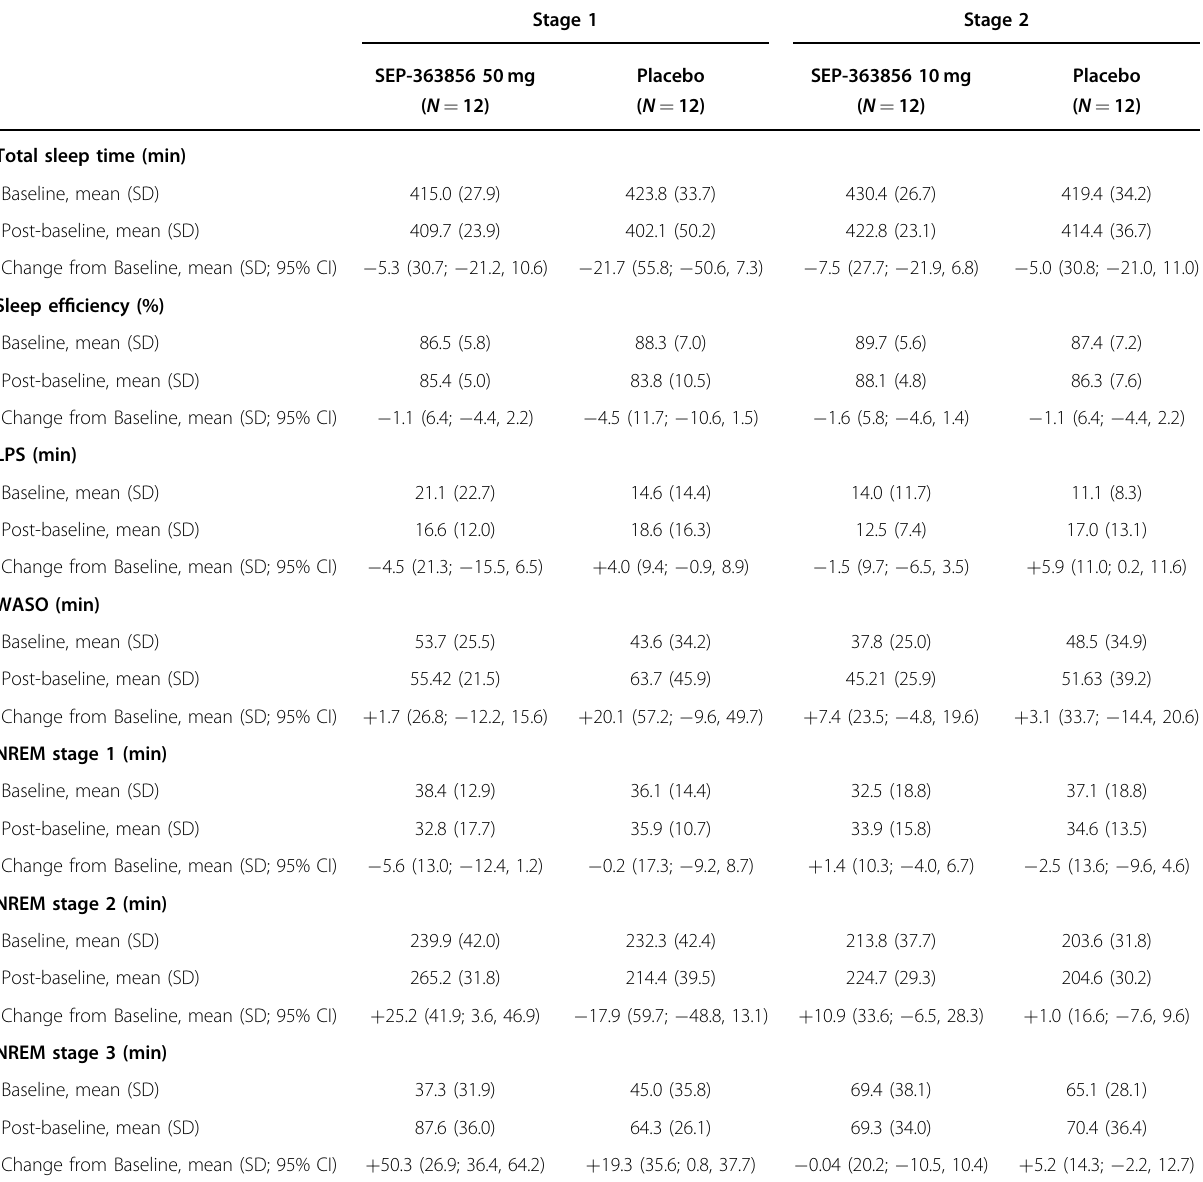
Table 3 Additional polysomnography parameters in healthy males ( N = 12 per dose cohort) during crossover treatment with SEP-363856 (10 mg or 50 mg) vs.